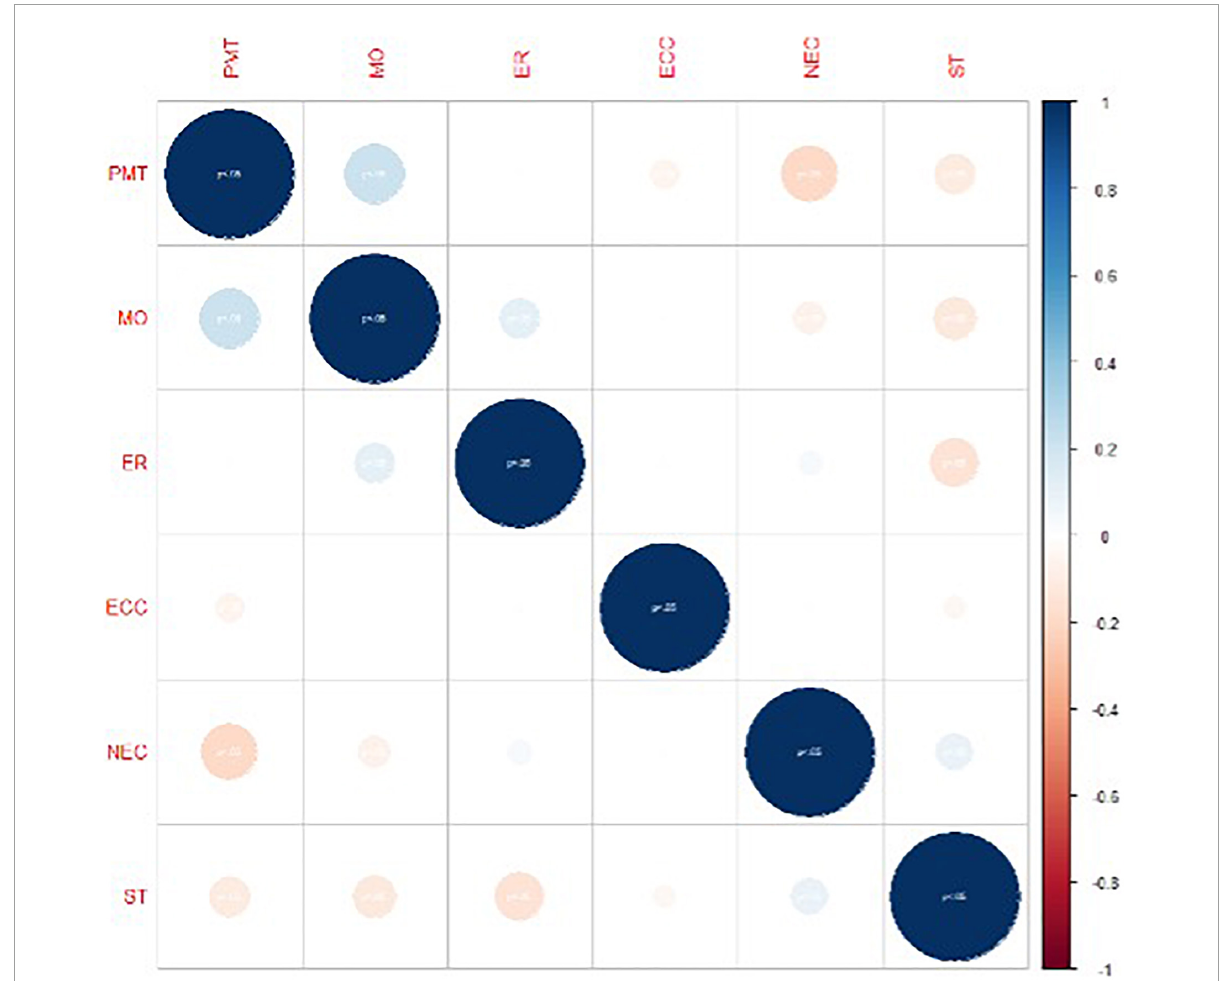
FIGURE4 Correlation between the variables gender, educational level, teaching, study time, resources used, and